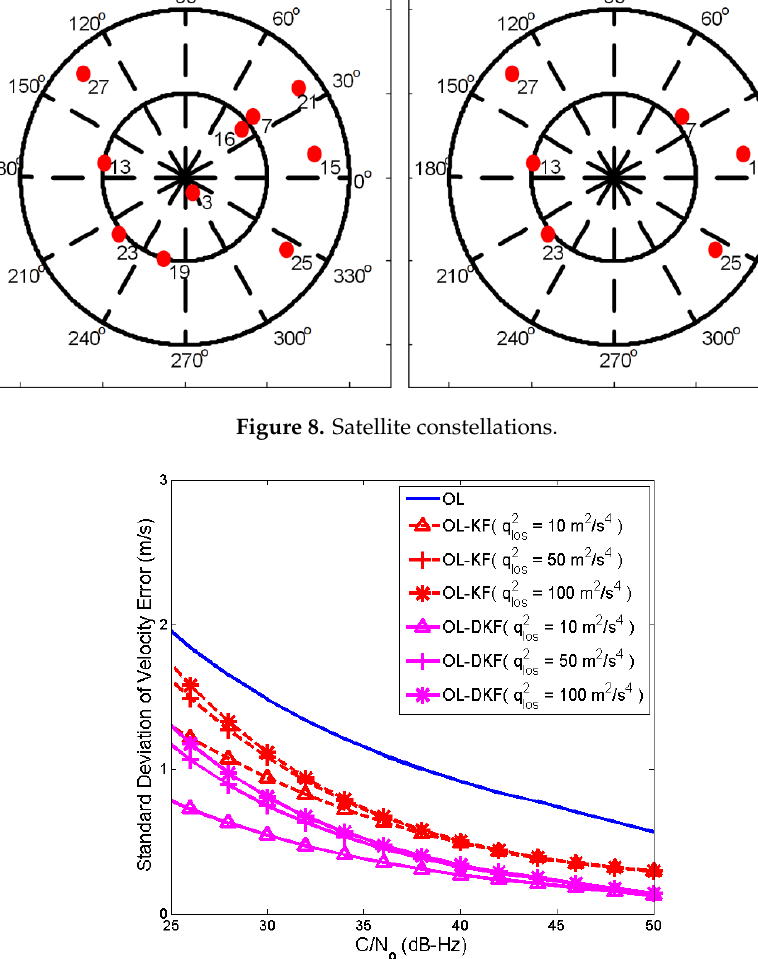
Figure 9. Standard deviation of the velocity error (10 sats).